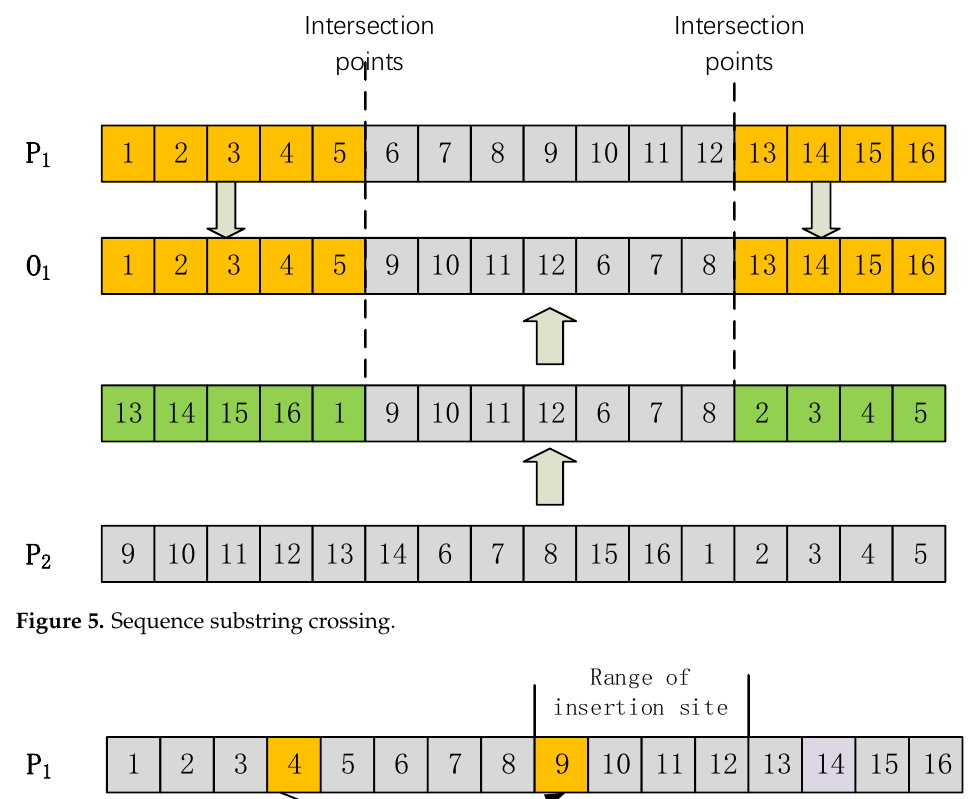
Figure 6. Sequential substring variation.